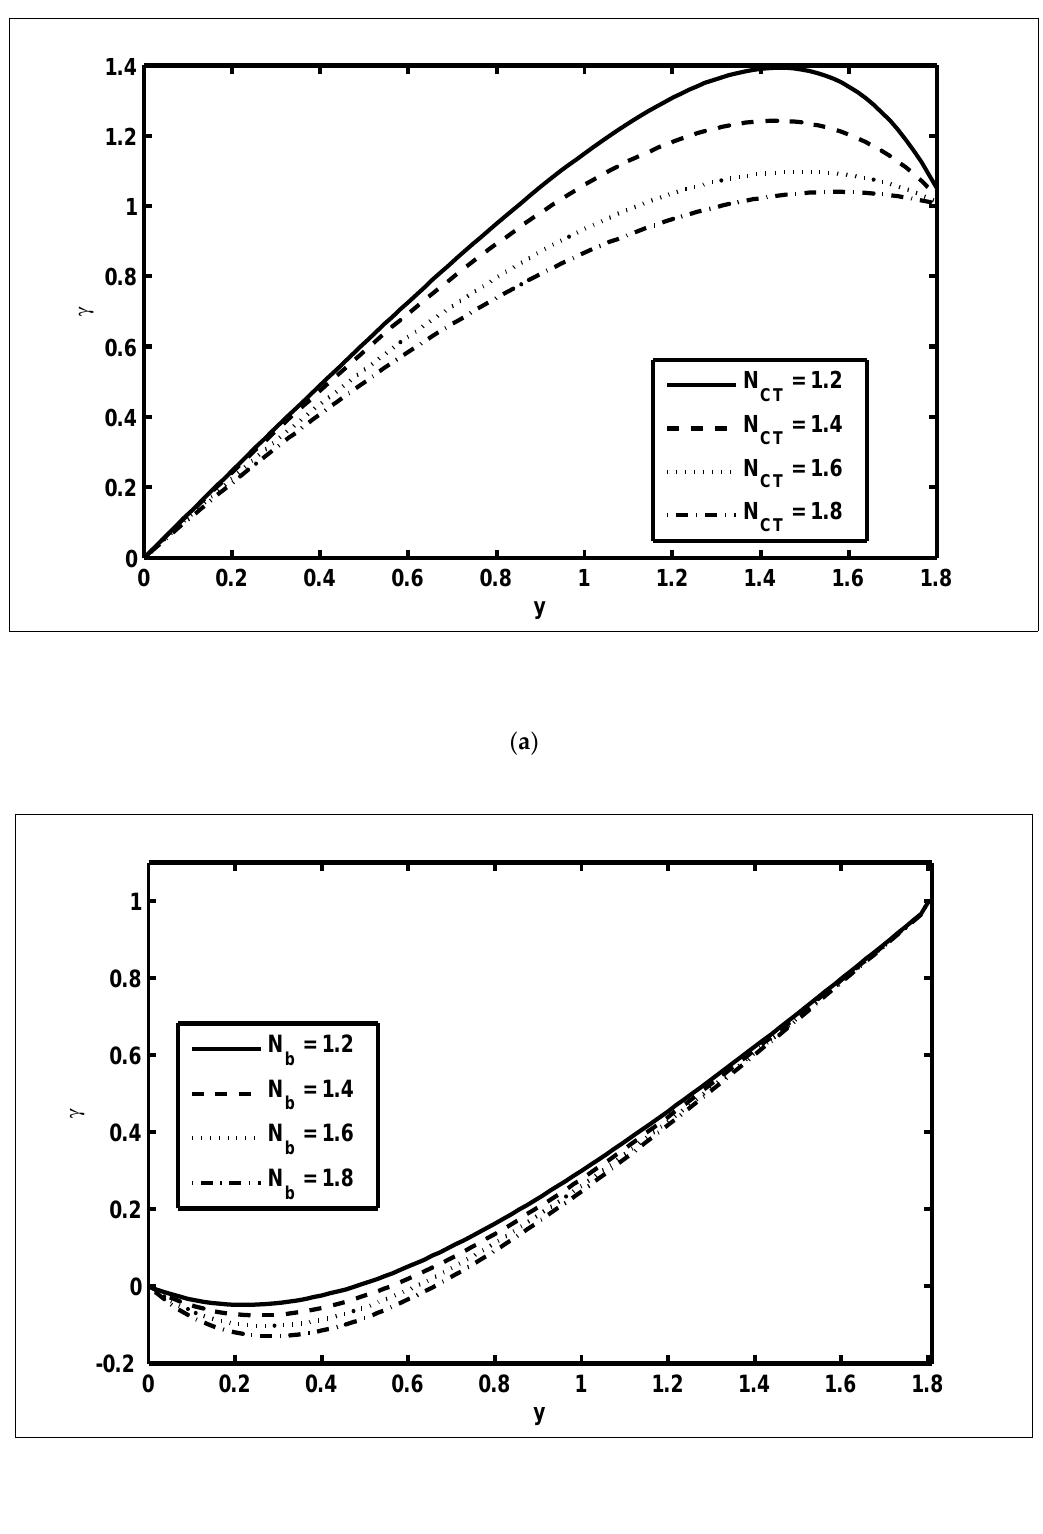
Figure 6. The solute concentration profiles ( 𝛾 ): ( a ) 𝑁 𝐶𝑇 = 0.9, 𝑁 𝑇𝐶 = 0.7, 𝑁 𝑡 = 0.9, 𝛽 = 0.4, 𝑚 = 0.2, 𝑥 = 0.2 ; ( b ) 𝑁 𝐶𝑇 = 0.9, 𝑁 𝑏 = 0.7, 𝑁 𝑡 = 0.9, 𝛽 = 0.4, 𝑚 = 0.2, 𝑥 = 0.2.